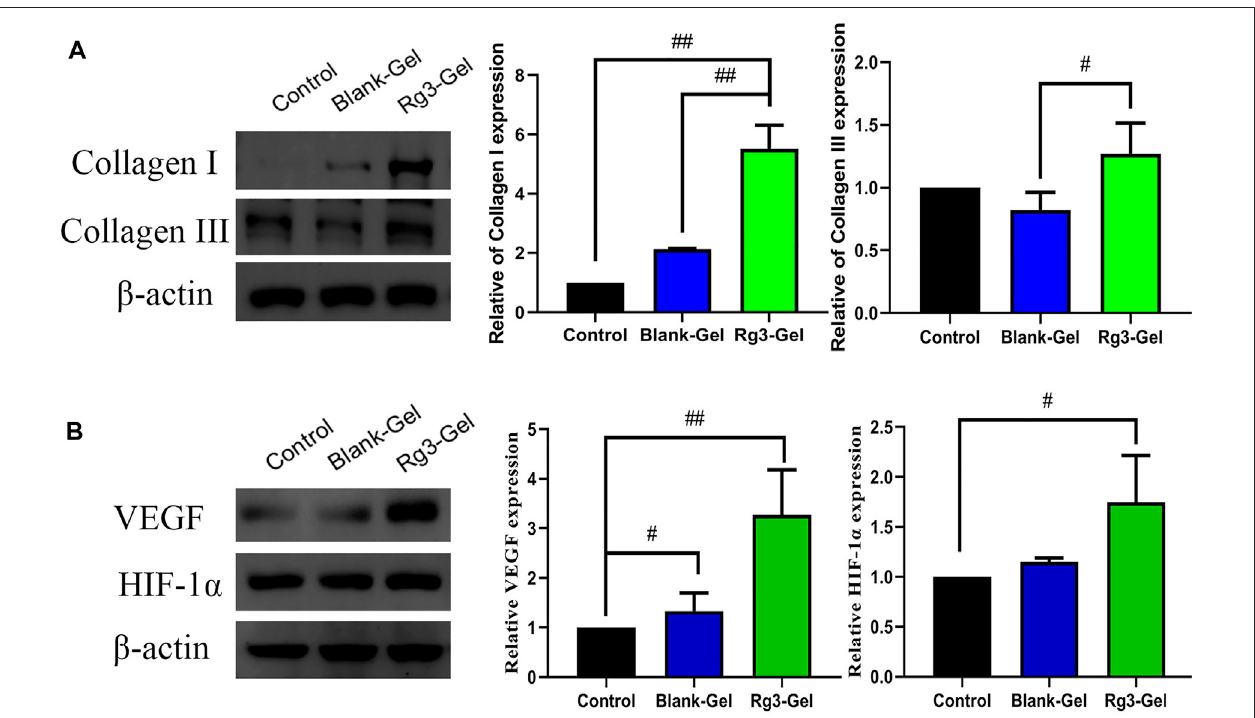
FIGURE 6 | Effects of Rg3-Gel on collagen and angiogenesis at wound-healing sites. (A) Representative western blots and their quantitative analysis of Collagen I andCollagenIIIproteinsinskintissueofthreegroups. (B) RepresentativewesternblotsandtheirquantitativeanalysisofVEGFandHIF-1 α proteinsinskintissueofthree groups (# p < 0.05, ## p < 0.01, and n =